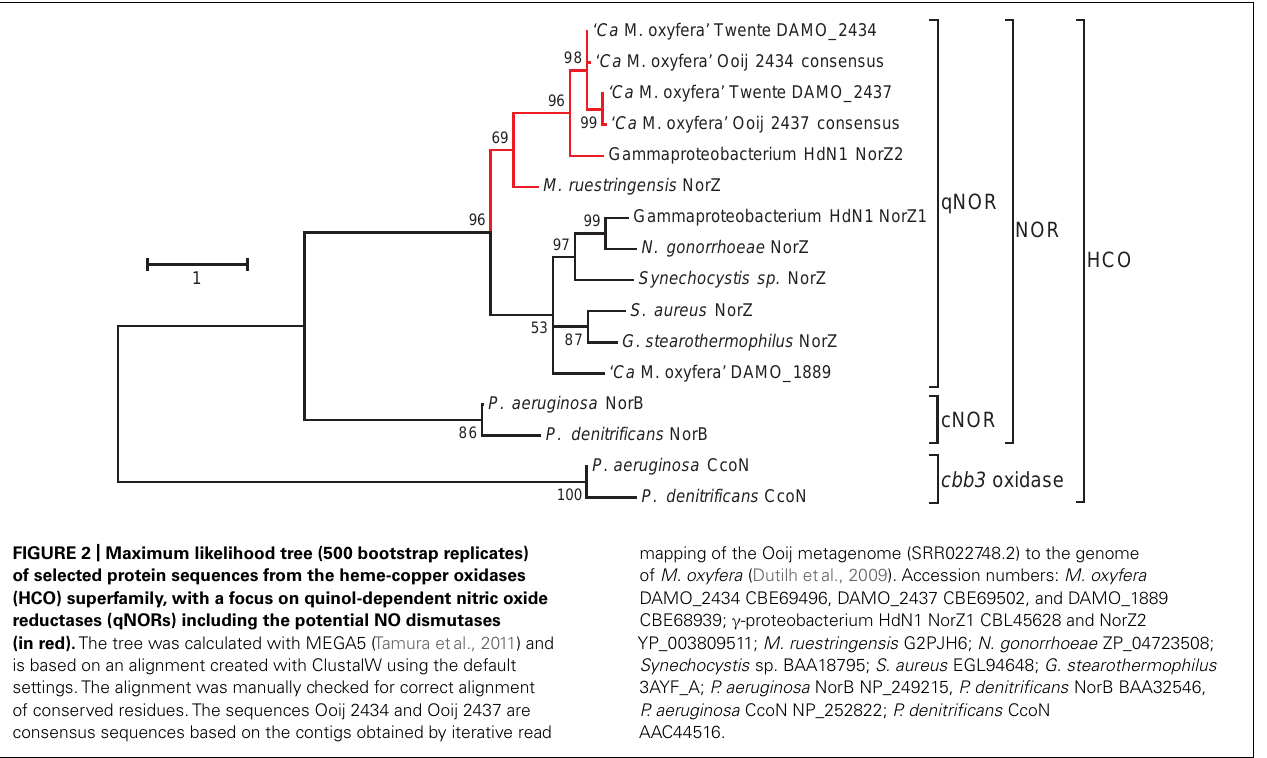
FIGURE 2 | Maximum likelihood tree (500 bootstrap replicates) of selected protein sequences from the heme-copper oxidases (HCO) superfamily, with a focus on quinol-dependent nitric oxide reductases (qNORs) including the potential NO dismutases (in red). The tree was calculated with MEGA5 (Tamura etal., 2011) and is based on an alignment created with ClustalW using the default settings.The alignment was manually checked for correct alignment of conserved residues.The sequences Ooij 2434 and Ooij 2437 are consensus sequences based on the contigs obtained by iterative